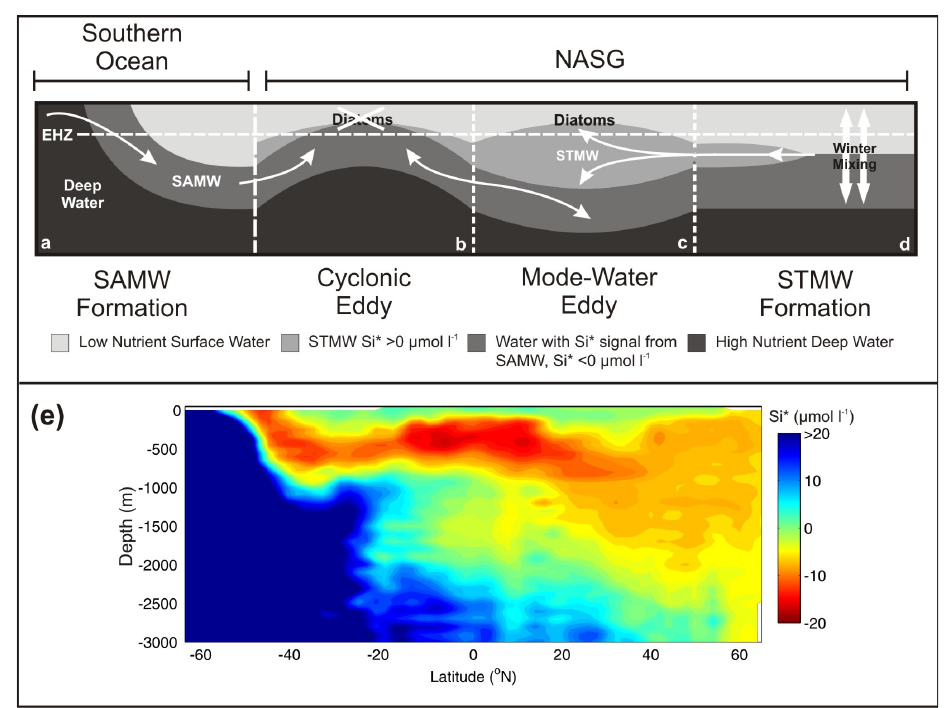
Fig. 6. Proposed model of the source of nutrients that affect the thermocline in the North Atlantic Sub-tropical Gyre (NASG). The figure shows a stylized section of Si ∗ in both the Southern Ocean and the NASG. Sub-Antarctic Mode-Water (SAMW), where a negative Si ∗ is formed in Antarctica from upwelling of nutrient-rich deep waters followed by subsequent northward Ekman transport and concurrent preferential silicate removal (a) . Water with a Si ∗ signal derived from SAMW is transported north and can reach the thermocline in the NASG through the action of mesoscale cyclonic eddies (b) , but is downwelled by the action of mesoscale mode-water eddies (c) and uncoupled from the thermocline. Winter mixing of SAMW and surface water (d) on the northern boundary of the NASG leads to the formation of sub-tropical mode water (STMW) with positive Si ∗ that impacts the base of the euphotic zone (EHZ, dashed horizontal line) in the NASG through the action of mesoscale mode-water eddies (c) . This mechanism determines whether the phytoplankton community stimulated by mesoscale eddies can sustain significant diatom populations. (e) Latitudinal section of Si ∗ through the Atlantic from GLODAP